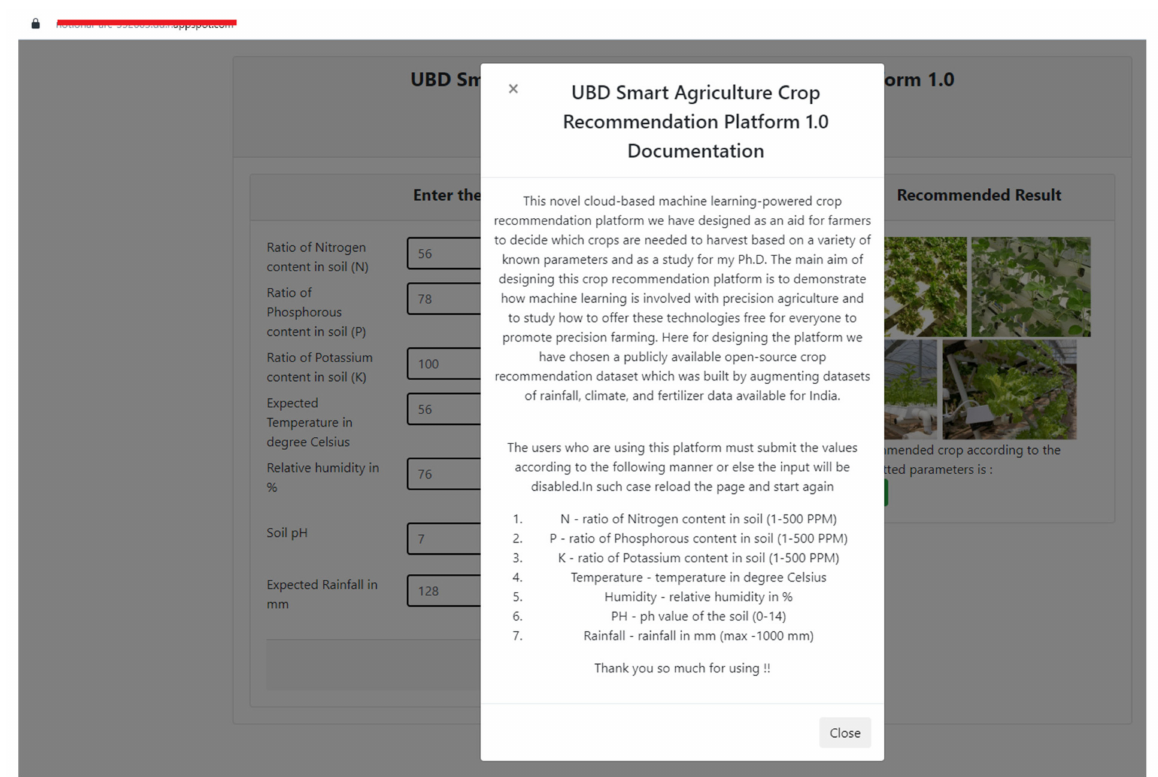
Figure 11. Cloud-hosted crop recommendation platform.